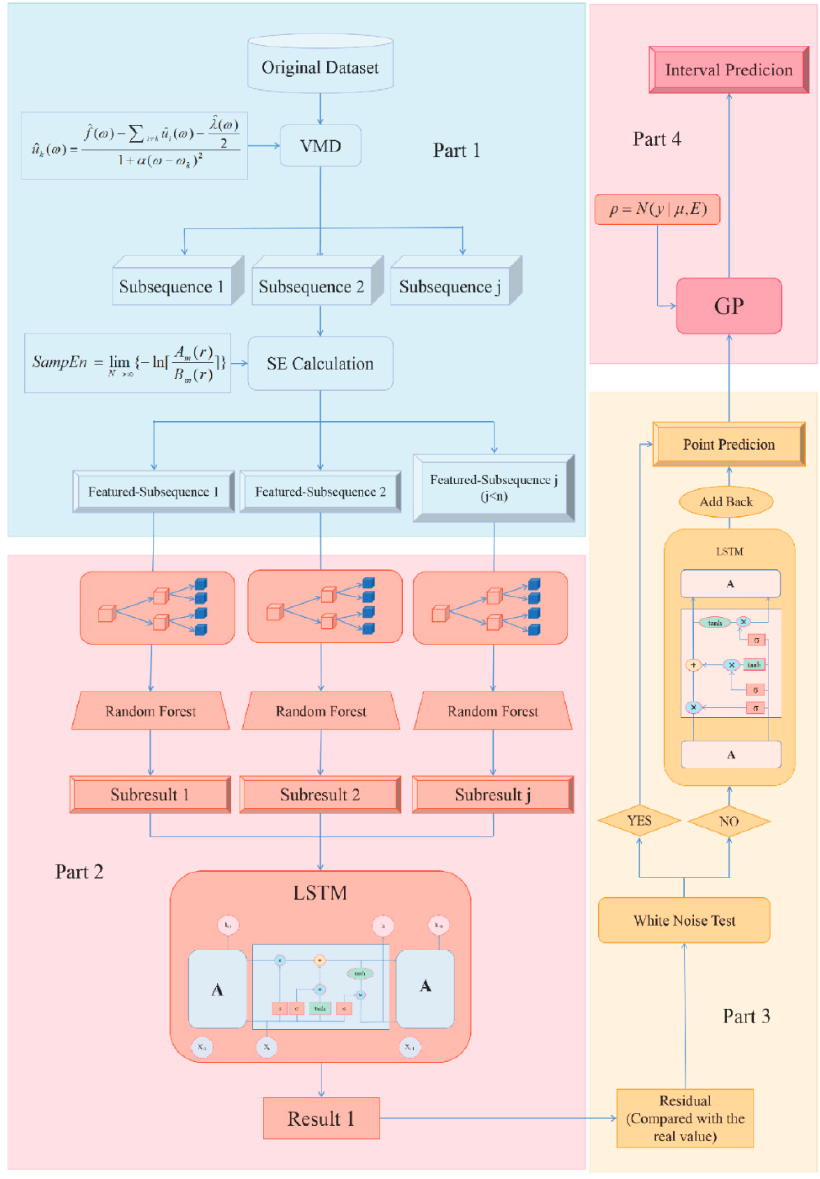
Figure 2. Flowchart of the proposed